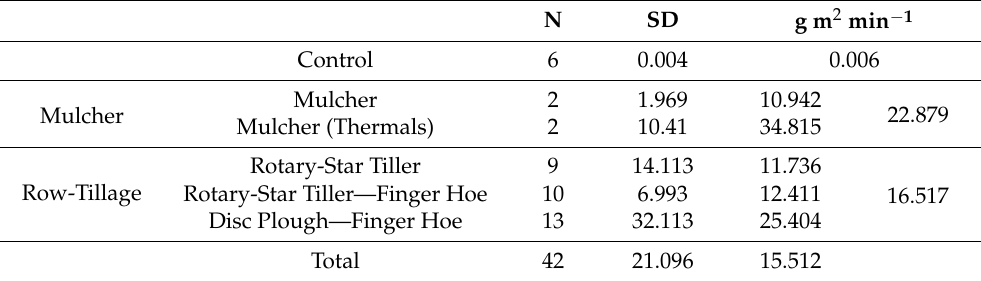
Table 2. Mean dust flux for cultivation operations .